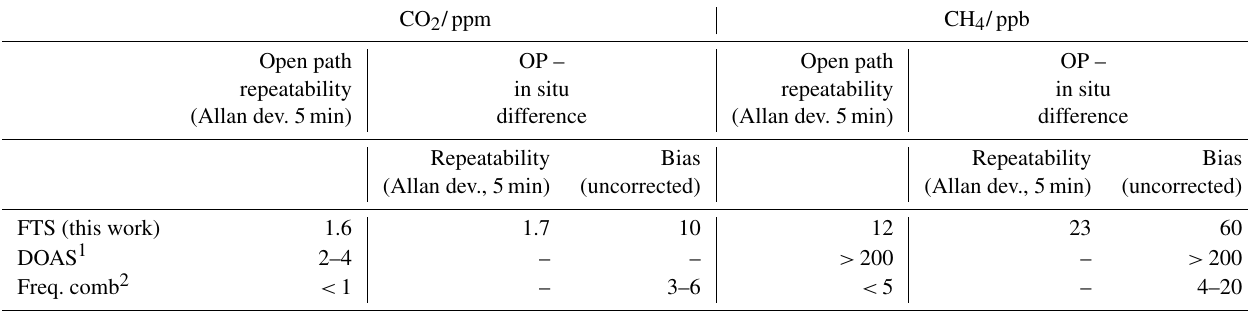
Table 4. Comparison of repeatability and bias of long path techniques in the NIR